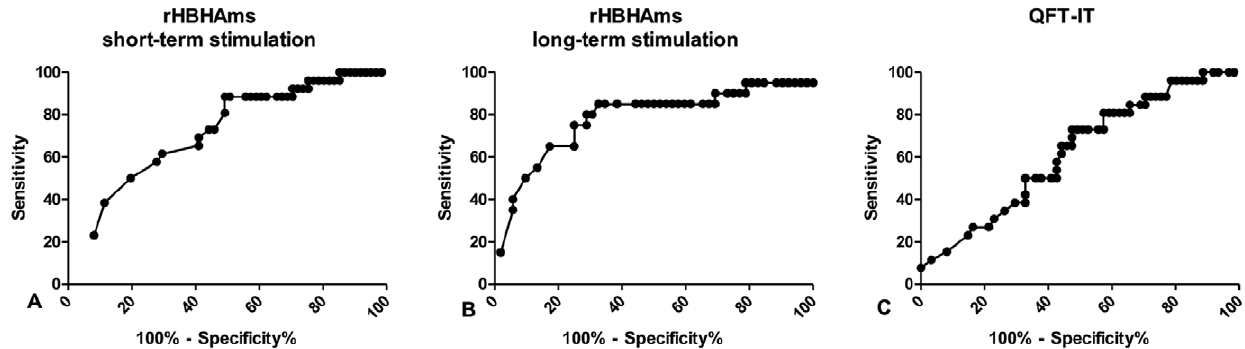
Figure 4. IFN- c response to rHBHAms in short- and long-term-‘‘ invitro ’’ stimulation and to QFT-IT: ROC analysis. A ROC analysis for the response to rHBHAms obtained in whole blood by short-term stimulation ( A ), long- term stimulation ( B ) and QFT-IT ( C ) was performed using the active TB patients and the subjects without active TB as comparator groups.